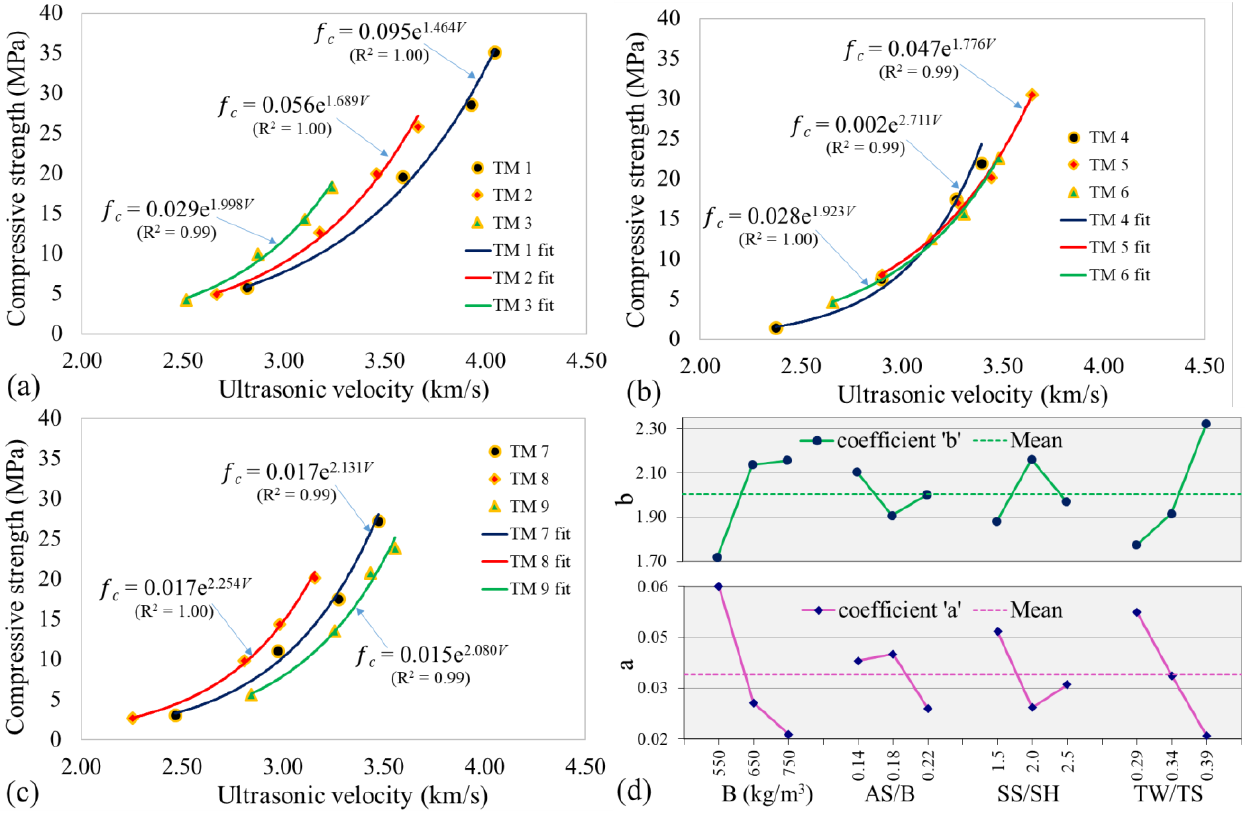
Figure 10. Ultrasonic velocity and compressive strength ( a ) TM 1–TM 3, ( b ) TM 4–TM 6, ( c ) TM 7–TM 9, ( d ) exponential function coefficients.